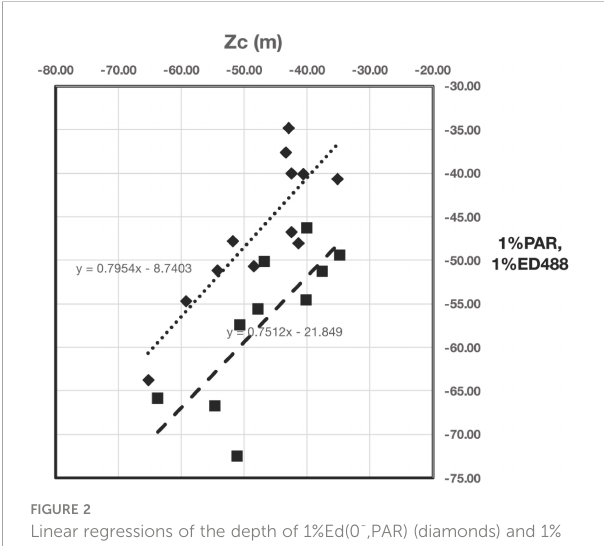
FIGURE 2 Linear regressions of the depth of 1%Ed(0 - ,PAR) (diamonds) and 1% Ed(488) (squares) with Zc (x-axis). The slope of the regression of 1% Ed(0 - ,PAR) on Zc is not signi fi cantly different from